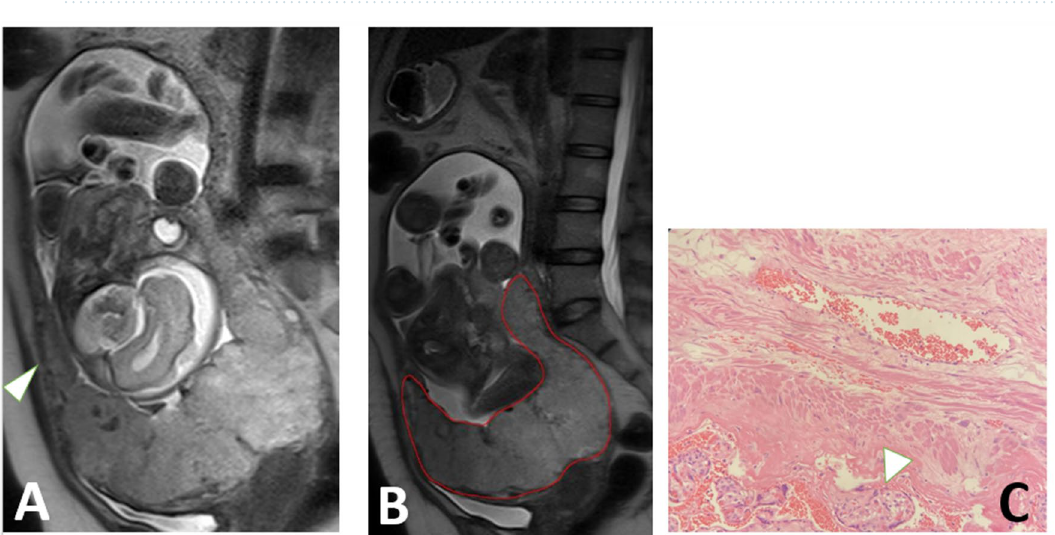
Figure 5. A 35-year-old gravid woman with placenta previa at 34.2 GW. The placenta increta (arrowhead) were clearly displayed at the lower uterine segment on sagittal T2WI ( A ). The computerized model automatically drew the contour of placenta and gave the prediction probability of 0.877 in placenta increta ( B ). The histological picture disclosed the placenta villi (arrowhead) among the muscular vessels in the uterus (HE × 100, C